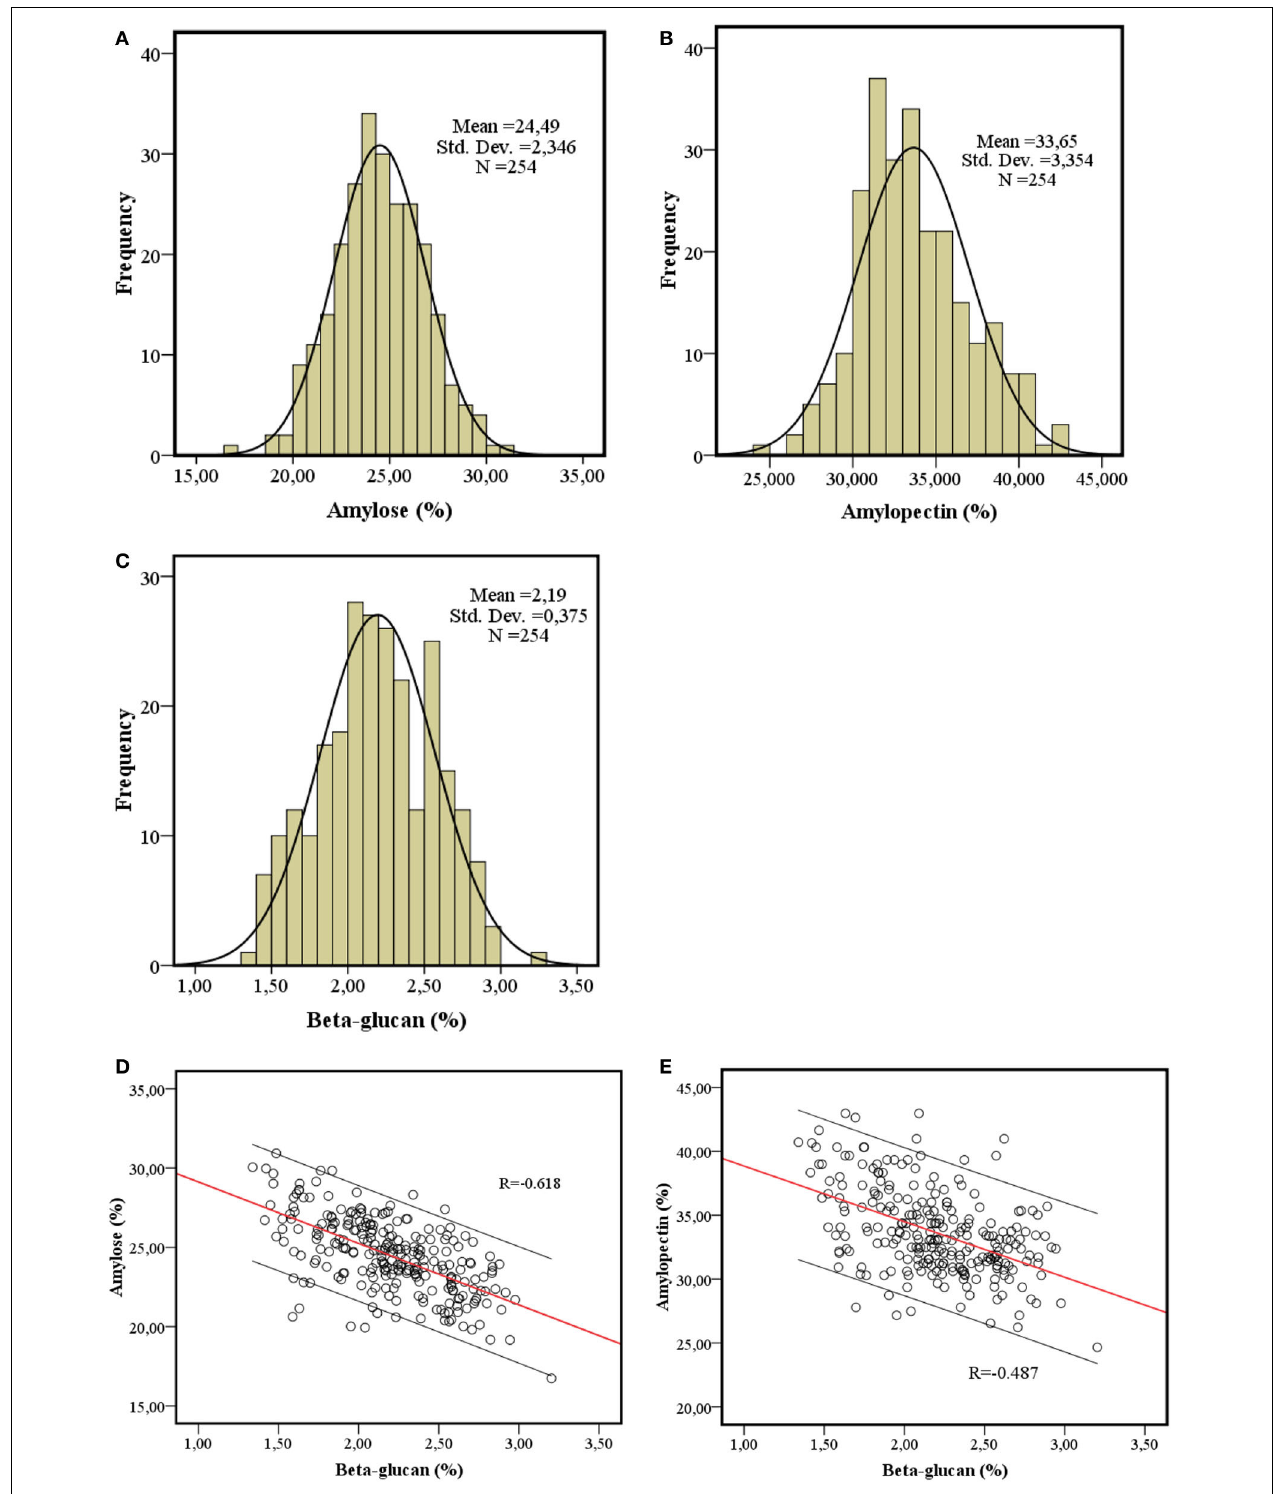
FIGURE 1 | Quantification of barley grain constituents. The distribution of amylose content (A) , amylopectin content (B) and β -glucan content (C) and the correlation between amylose content and β -glucan content (D) , amylopectin content and β -glucan content (E) in 254 barley spring cultivars.